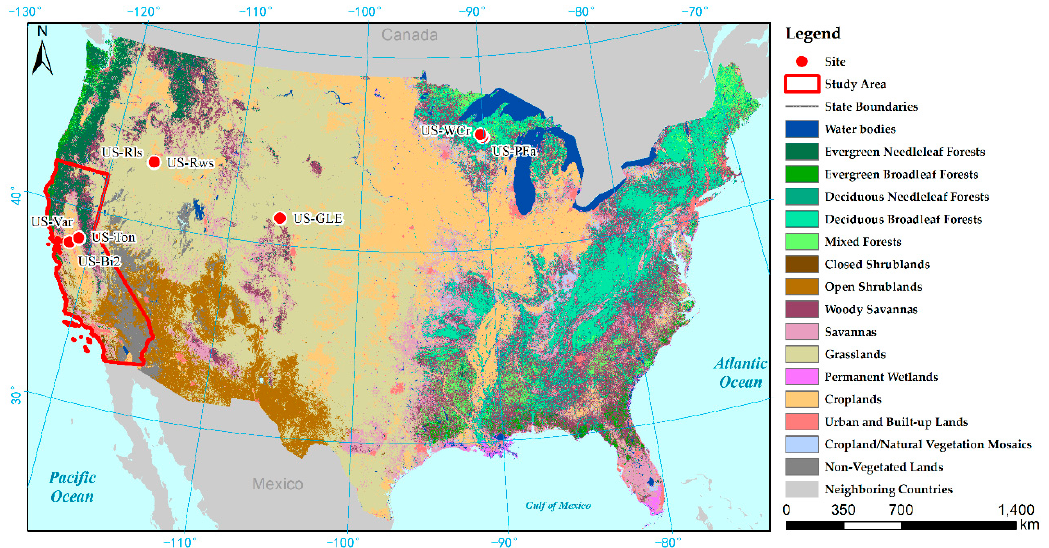
Figure 1. The geographical location of AmeriFlux sites and research areas employed in this study.